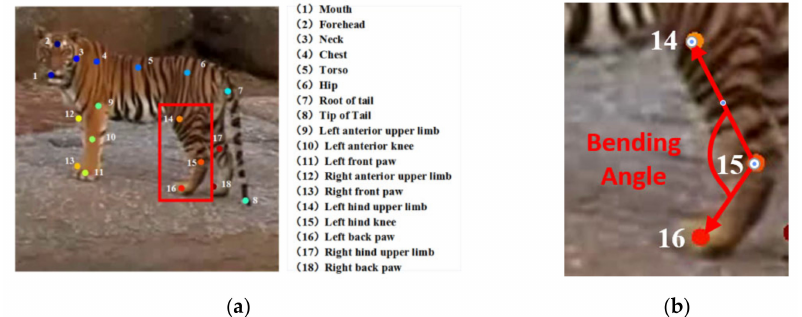
Figure 5. Joint point-labeled skeleton: ( a ) the eighteen tracked points; ( b ) the bending degrees of the knee joints (zoom